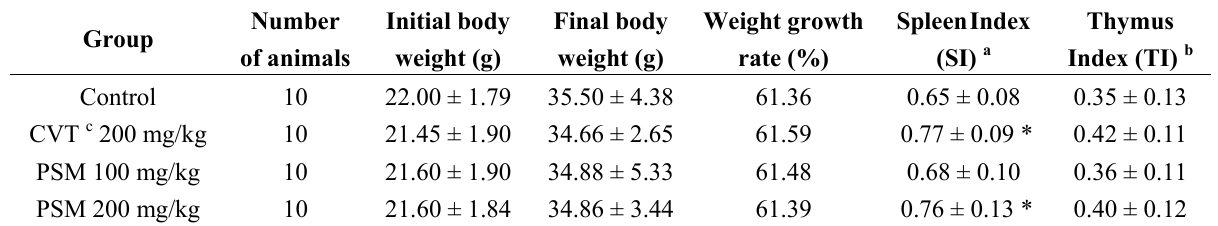
Table 2. The effects of PSM on immune organs in normal